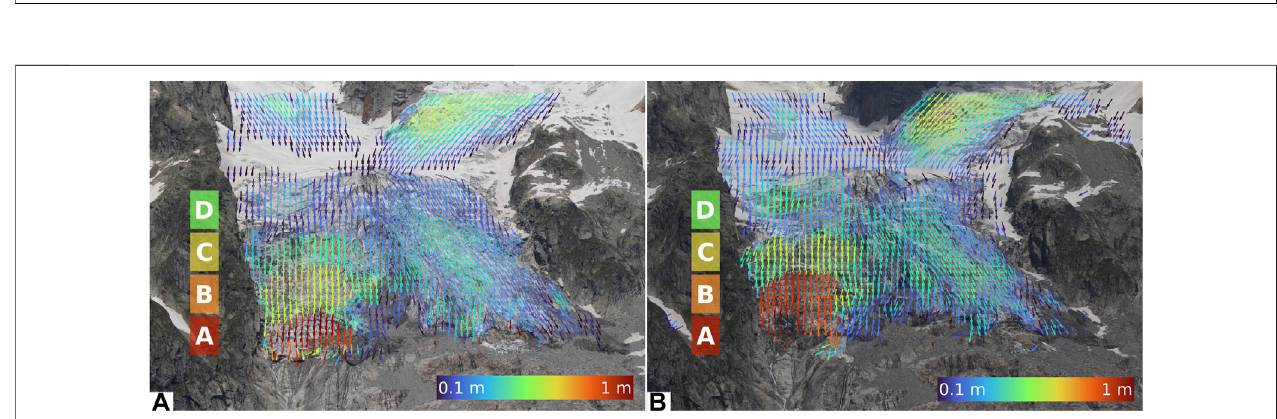
FIGURE8| Bedrockand glacier surfaceundulationsobtained bysubtracting aquadratic fi tfrom theelevation pro fi les. (A – E) and (G – K) Surfaceundulationsalong pro fi lesn.14and15,respectively,in2014,2017,2018,2019and2020; (F – L) bedrockundulationsalongpro fi lesn.14and15.Thedashedblacklineistheinterpolating sine function. (M,N) Interpolating sin function of every undulation curve for pro fi les n. 14 and 15, respectively.